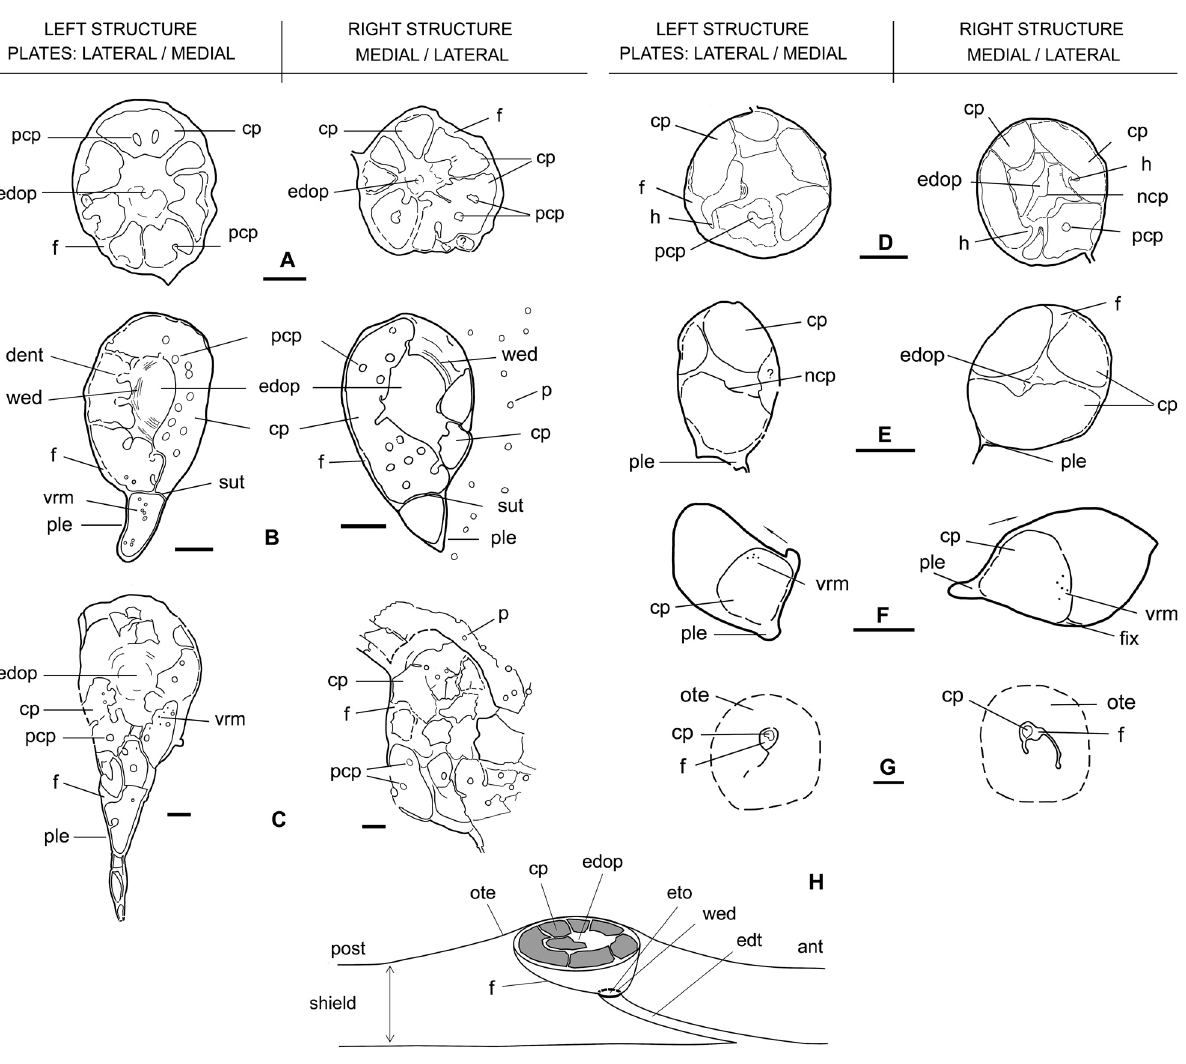
Fig. 2. Line drawings of endolymphatic structures. A , Tremataspis schmidti Rohon; B – D , Tremataspis milleri Patten; E , Tremataspis rohoni Robertson; F , G , Tremataspis mammillata Patten; H , diagram of a representative external endolymphatic structure in Tremataspis . Scale bar = 100 µm (A–F); 400 µm (G). Abbreviations for Figures 2–9 : ant, anterior; cap, very small cap-like platelet; cp, covering platelet; dent, dentate margin of a covering platelet or shield; dmf, dorsal median field; edop, endolymphatic duct opening among covering platelets; edt, endolymphatic duct tube; eto, endolymphatic tube opening; f, funnel; fix, fixing aid?; fr, fibrous, rope-like structure; h, hook-like end of a covering platelet; ncp, notch in a covering platelet; ote, otic elevation above the surrounding shield; p, pore of the sensory canal system; pcp, large pore in a covering platelet; pin, pineal structure; ple, posterior/postero-lateral extension; ppf, pores of a porous field/perforated bony septum; r, ridges; sc, sensory canal; sut, suture and/or discontinuity; t, any tube except an endolymphatic duct tube; vrm, microbial vermicular traces; wed, wall of endolymphatic